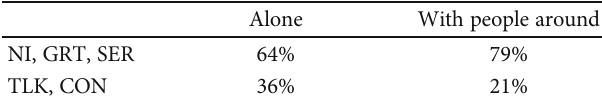
Figure 5: The nature and the length of conversations determine the “ type of conversation ” existed at a certain occasion. Here “ R ” and “ H ” represent the robot and the human user, respectively. Table 2: A comparison of conversational preferences by the type of interaction when the user was alone and when with few people